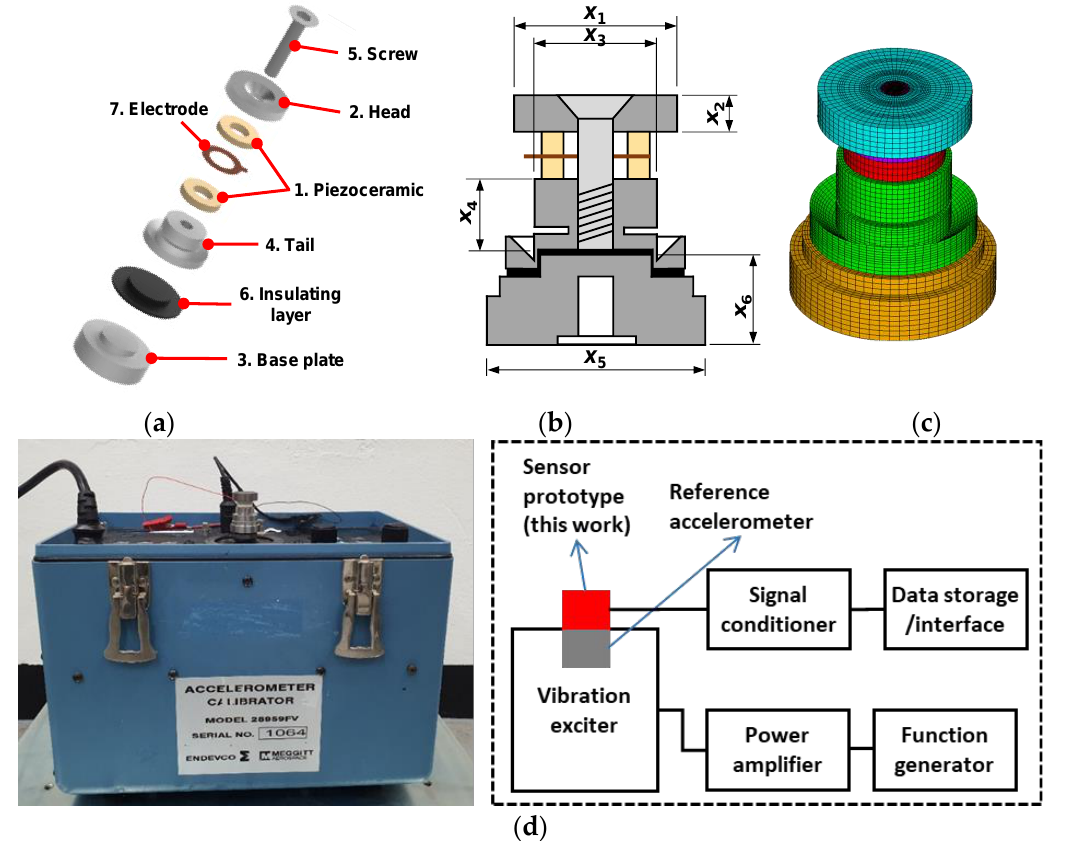
Figure 1. ( a ) Exploded diagram showing the constituent components of the compression-type piezoelectric accelerometer (1: piezoceramic ring; 2: head or seismic mass; 3: base plate; 4: tail; 5: screw; 6: insulating layer; 7: electrode). ( b ) Design variables used for finite element modeling ( x 1 : head outer diameter, x 2 : head height, x 3 : tail outer diameter (O.D.), x 4 : tail height, x 5 : base outer diameter (O.D.), x 6 : base height). ( c ) Finite element model of a compression-mode accelerometer (total number of elements: 124,800, number of nodes: 134,977). ( d ) A photo showing experimental setup of the vibration test and its block diagram.